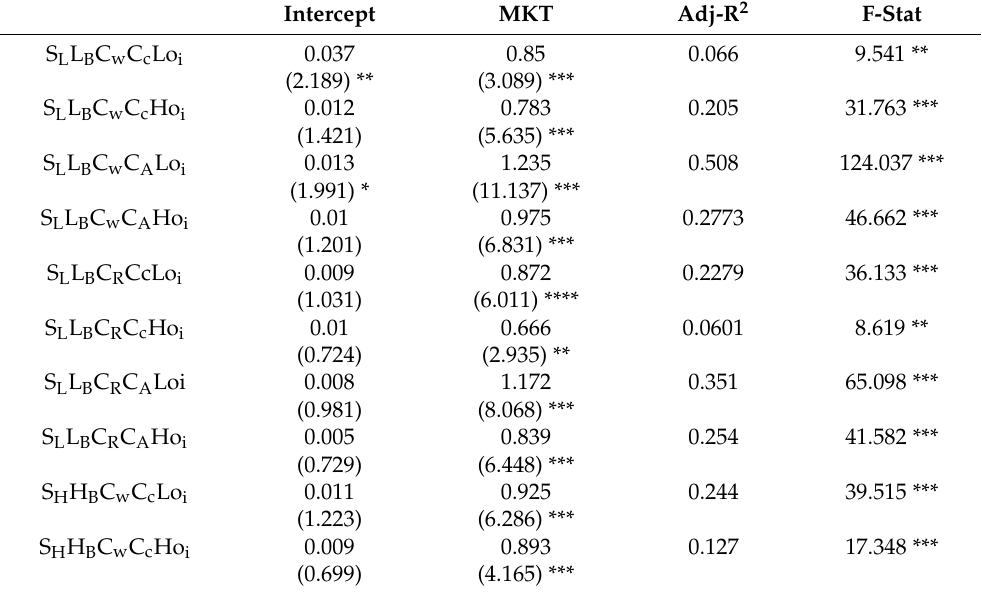
Table 5. Capital Asset Pricing Model